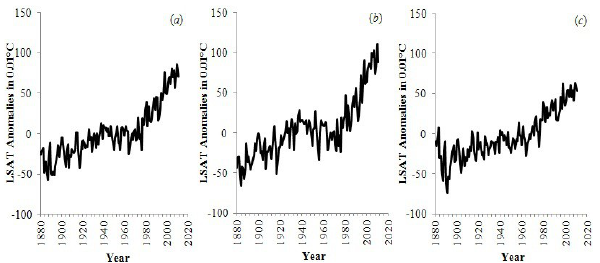
Fig. 3. Double logarithmic plot (10-base logarithms) of the root- mean-square fluctuation function F d (τ) versus time interval τ (in years) for the detrended annual mean LSAT anomalies set (a) glob- ally with the best fit equation ( y = 0 . 68 x + 0 . 32 with R 2 = 0 . 97), (b) over the NH with the best fit equation ( y = 0 . 65 x + 0 . 43 with R 2 = 0 . 97), and (c) over the SH with the best fit equation ( y = 0 . 65 x + 0 . 37 with R 2 = 0 .